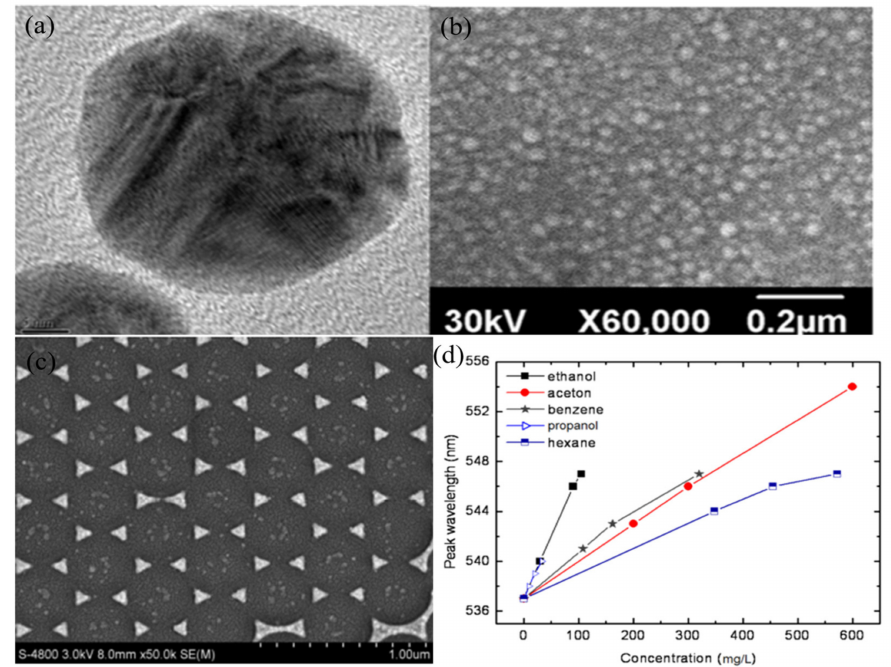
Figure 12. ( a ) TEM of Ag NPs/PVP/PVA composite, and ( b ) SEM of Ag NPs/PVP/PVA film on a glass plate, copied with permission from Ref. [156], Elsevier, 2015, ( c ) SEM of the triangular nanoprisms, and ( d ) calibration sensitivity curves of peak wavelength response to the concentrations of the tested vapors, copied with permission from Ref. [39], MDPI,